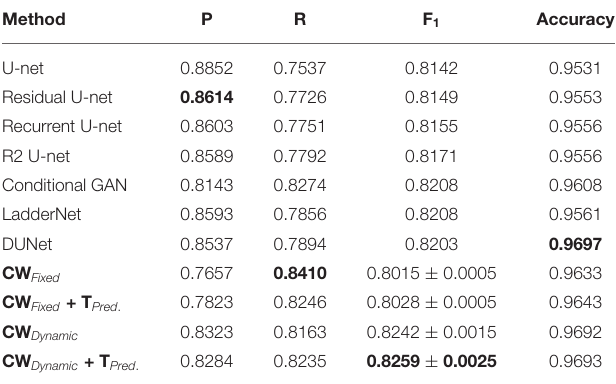
TABLE 1 | Results on DRIVE dataset.